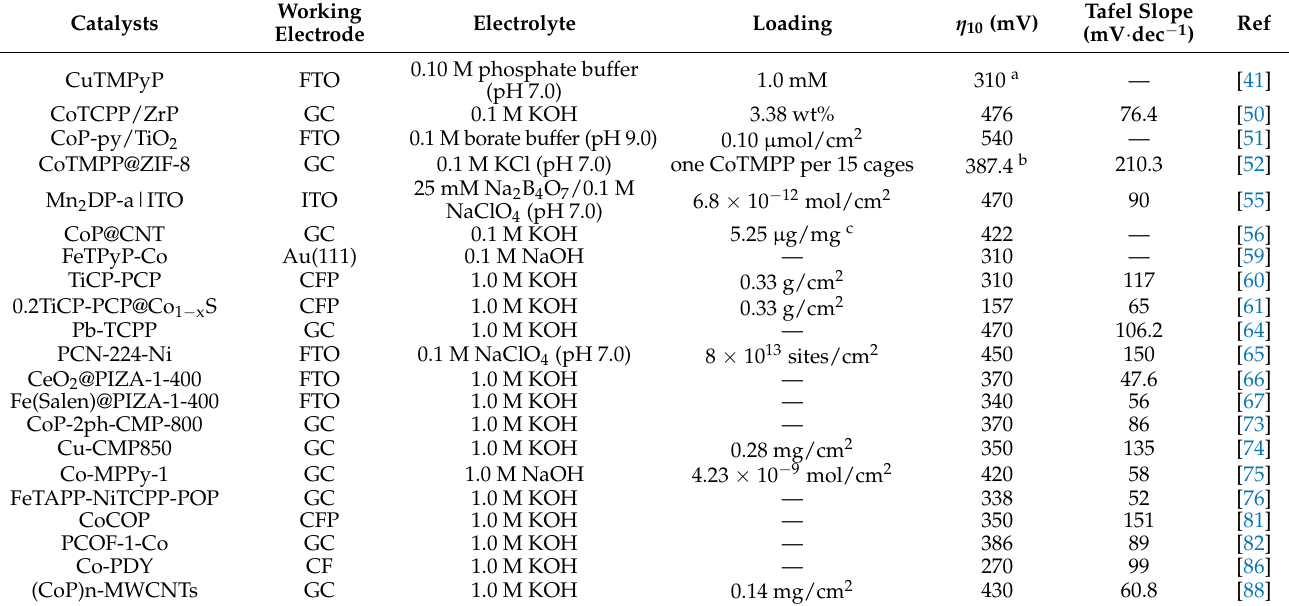
Table 1. Summarized performances of porphyrin-based materials for electrochemical OER.